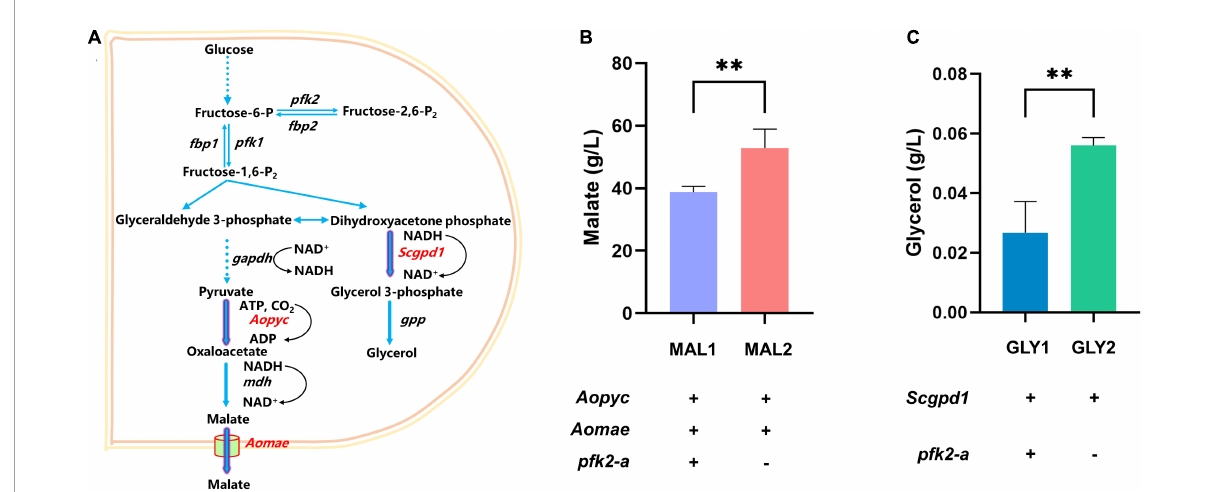
FIGURE5 Effects of the pfk2-a knockout on the promotion of metabolite production. (A) Schematic illustration of the malate and glycerol synthesis route in Myceliophthora thermophila . (B) Malate production with and without the pfk2-a deletion in the MAL1 and MAL2 strains during 6 days of shake flask fermentation. (C) Glycerol production with and without the pfk2-a deletion in the GLY1 and GLY2 strains during 6 days of shake flask fermentation. Values and error bars represent means and standard deviations of independent triplicate experiments, respectively. ∗∗ p <